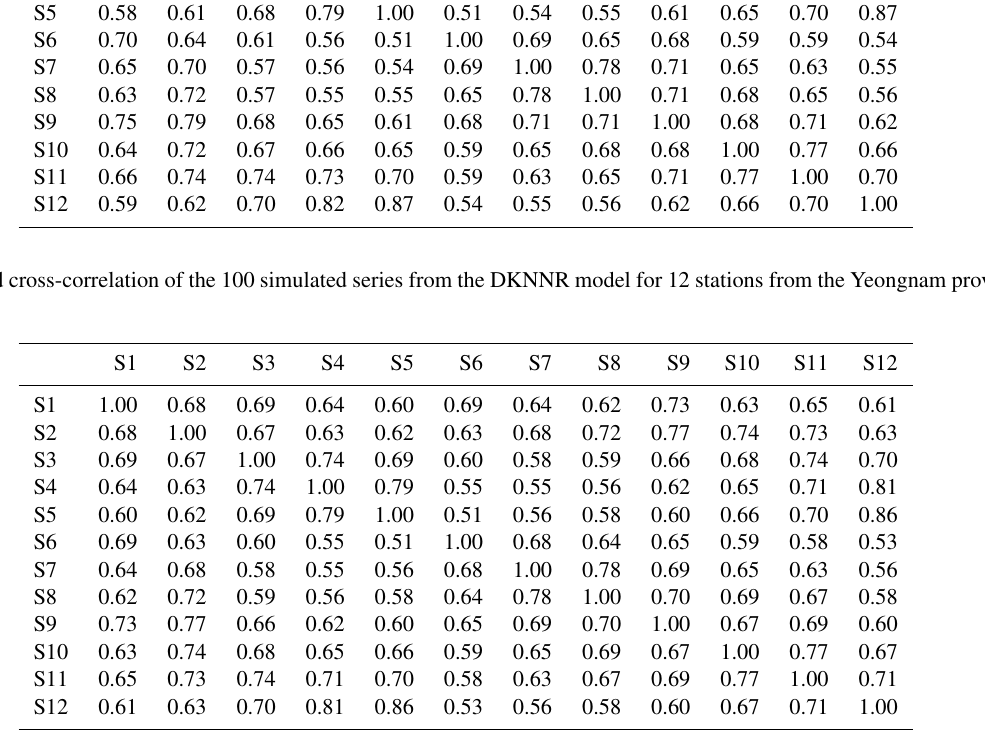
Table 5. Averaged cross-correlation of 100 simulated series from the MONR model for 12 stations from the Yeongnam